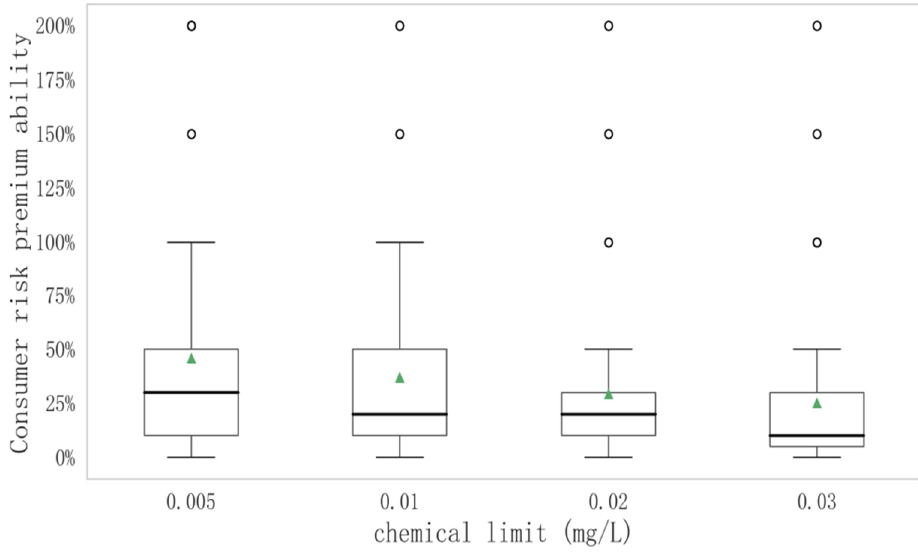
Figure 4. Consumer risk premium ability.